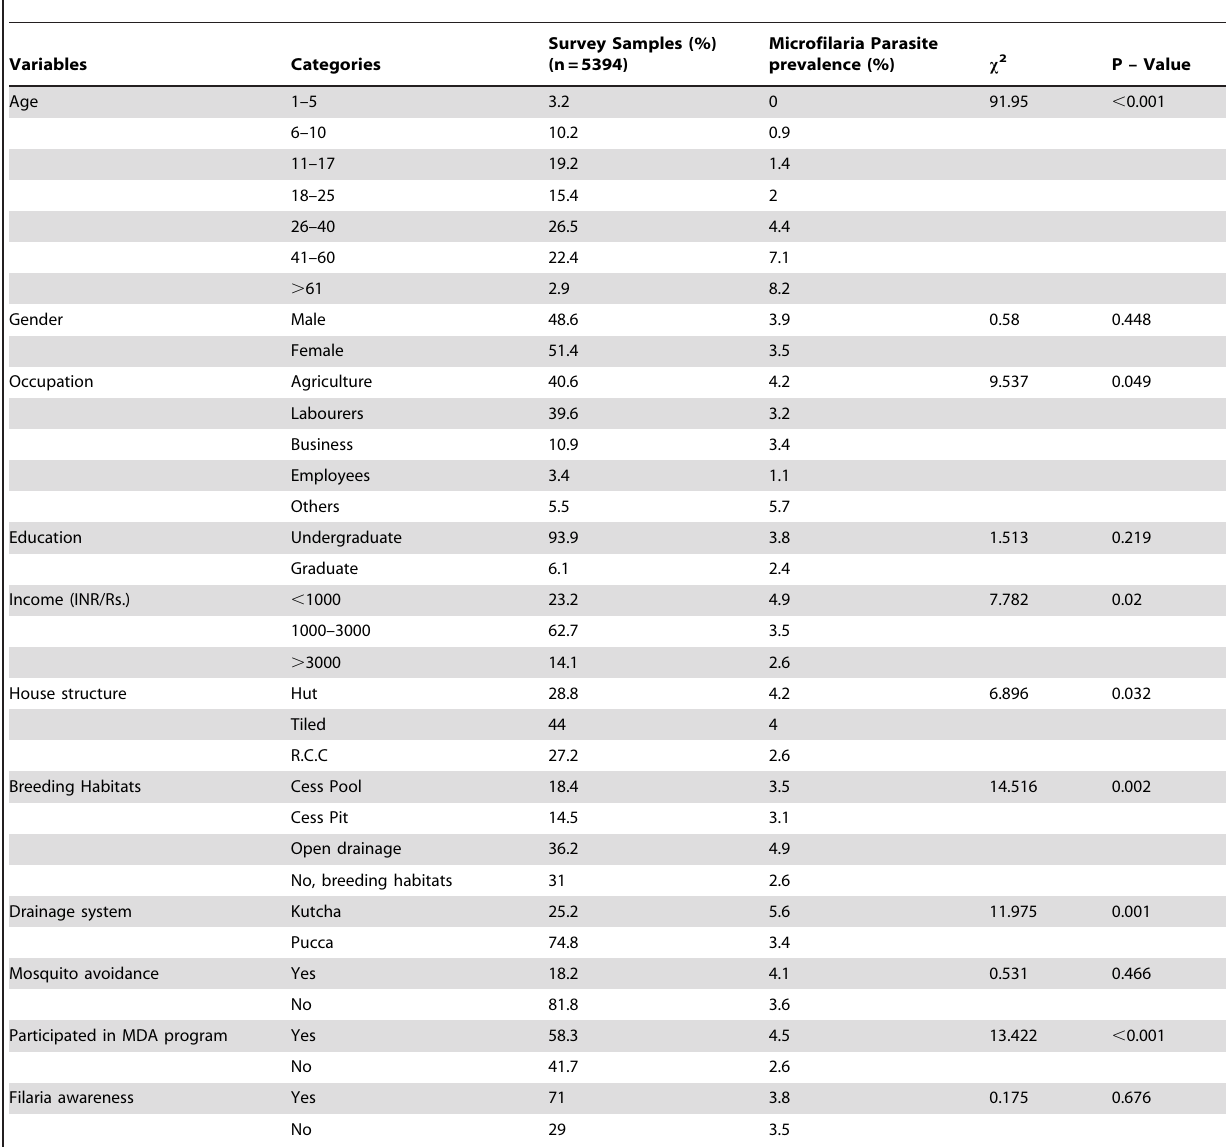
Table 1. Filaria prevalence, socioeconomic status and socioeconomic indexes used for principal component analysis in Karimnagar district of Andhra